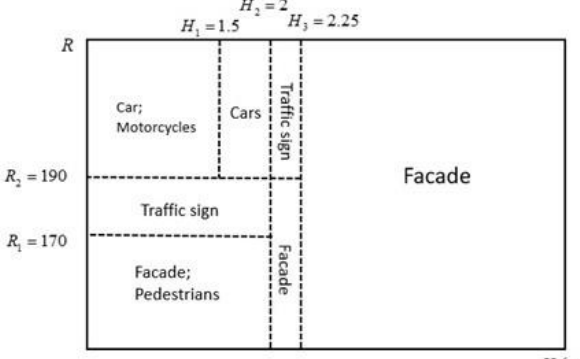
Figure 10. Knowledge on Height (H) and Reflectance (R) shown in a 2D feature space (Adopted from Zheng et al.,